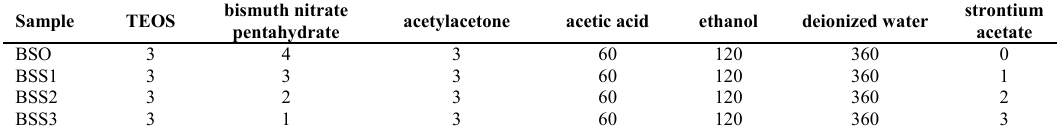
Table 1. Molar ratio of used materials for the preparation of different sols.